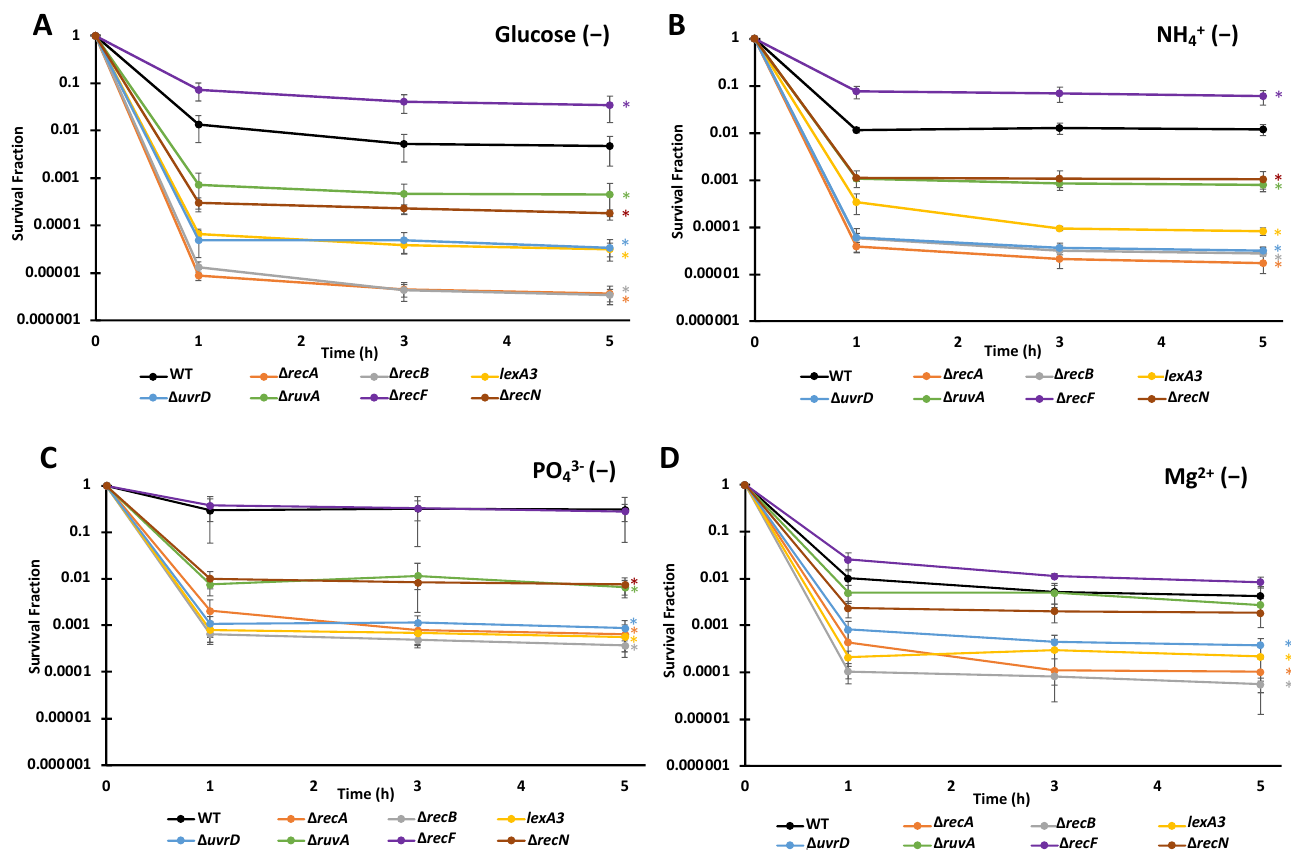
Figure 4. Importance of DNA repair machinery to MOXI persistence is largely invariant in non- growing populations starved for different nutrients. Persister levels in populations of ∆ recA , ∆ recB , lexA3, ∆ uvrD , ∆ ruvA , ∆ recF , ∆ recN and WT under the indicated starvation conditions were assessed with MOXI. Data points indicate the means of three biological replicates, whereas the error bars indicate the standard errors of those means. One-way ANOVA with post-hoc Tukey tests were con- ducted for each starvation conditions to assess significance. ( A , B ) Under C and N starvation ∆ recF exhibited significantly higher survival compared to WT at 1, 3, and 5 h. All other strains had signif- icantly lower survival rates than WT at these time points. ( C ) Under P starvation all strains except ∆ recF exhibited significantly lower survival rates when compared to WT at 1, 3, and 5 h time points. ( D ) ∆ recA , ∆ recB , lexA3, ∆ uvrD strains had a significantly lower survival rate compared to WT for Mg 2+ starvation at 1, 3, and 5 h. Significance was identified as p < 0.05.